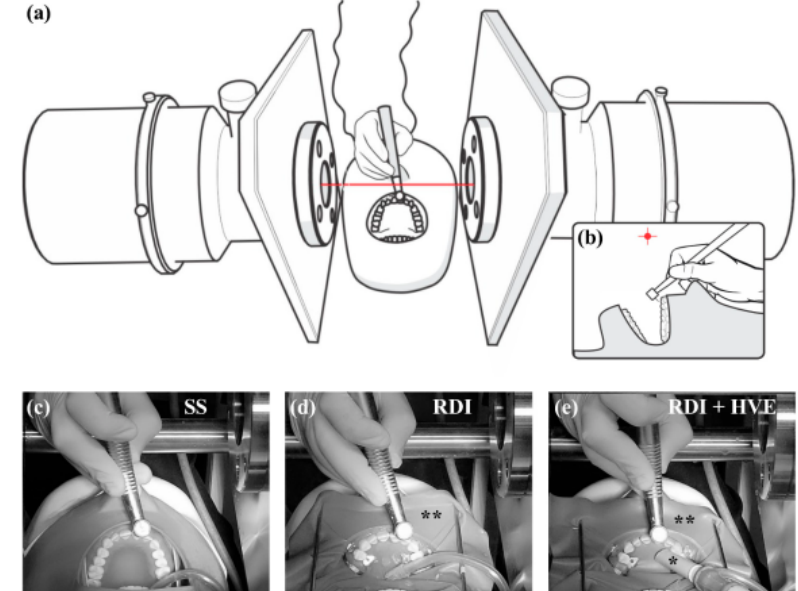
Figure 1. Experimental design using simulated patient and laser di ff raction for particle quantitation. ( a ) Description of the spatial relationship between the mannequin’s mouth and laser ray, demonstrating the location of the laser beam of the measurement device (Insitec S; Malvern Panalytical Ltd., Malvern, UK). ( b ) Scheme sagittal view showing the location of the laser beam (red dot with red cross) from the anterior teeth, at a linear distance of 11 cm. ( c – e ) Screenshots from the recorder experiments showing the three conditions: ( c ) standard suction (SS) with a saliva ejector; ( d ) rubber dam isolation plus standard suction (RDI); ( e ) rubber dam isolation plus high-volume suction (RDI + HVE) using both the standard suction (saliva ejector) and the high-volume evacuator (straight tip). *: